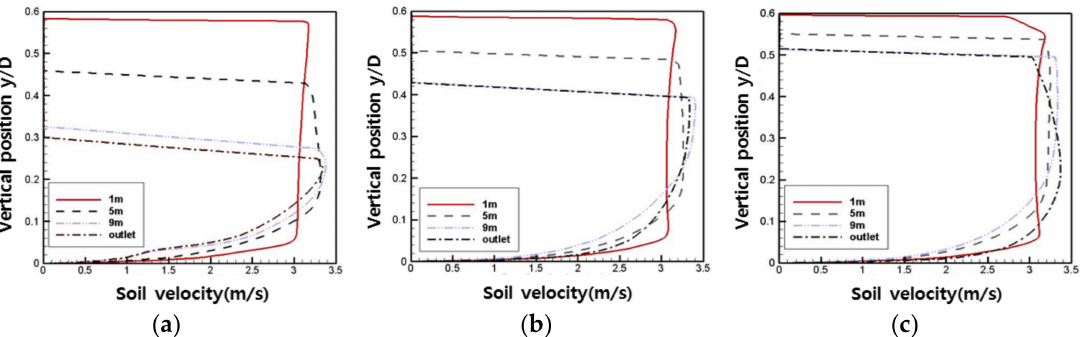
Figure 10. Soil velocity and soil diameter according to change in volume fraction. ( a ) Soil velocity distribution at a volume fraction of 10%; ( b ) Soil velocity distribution at a volume fraction of 30%; ( c ) Soil velocity distribution at a volume fraction of